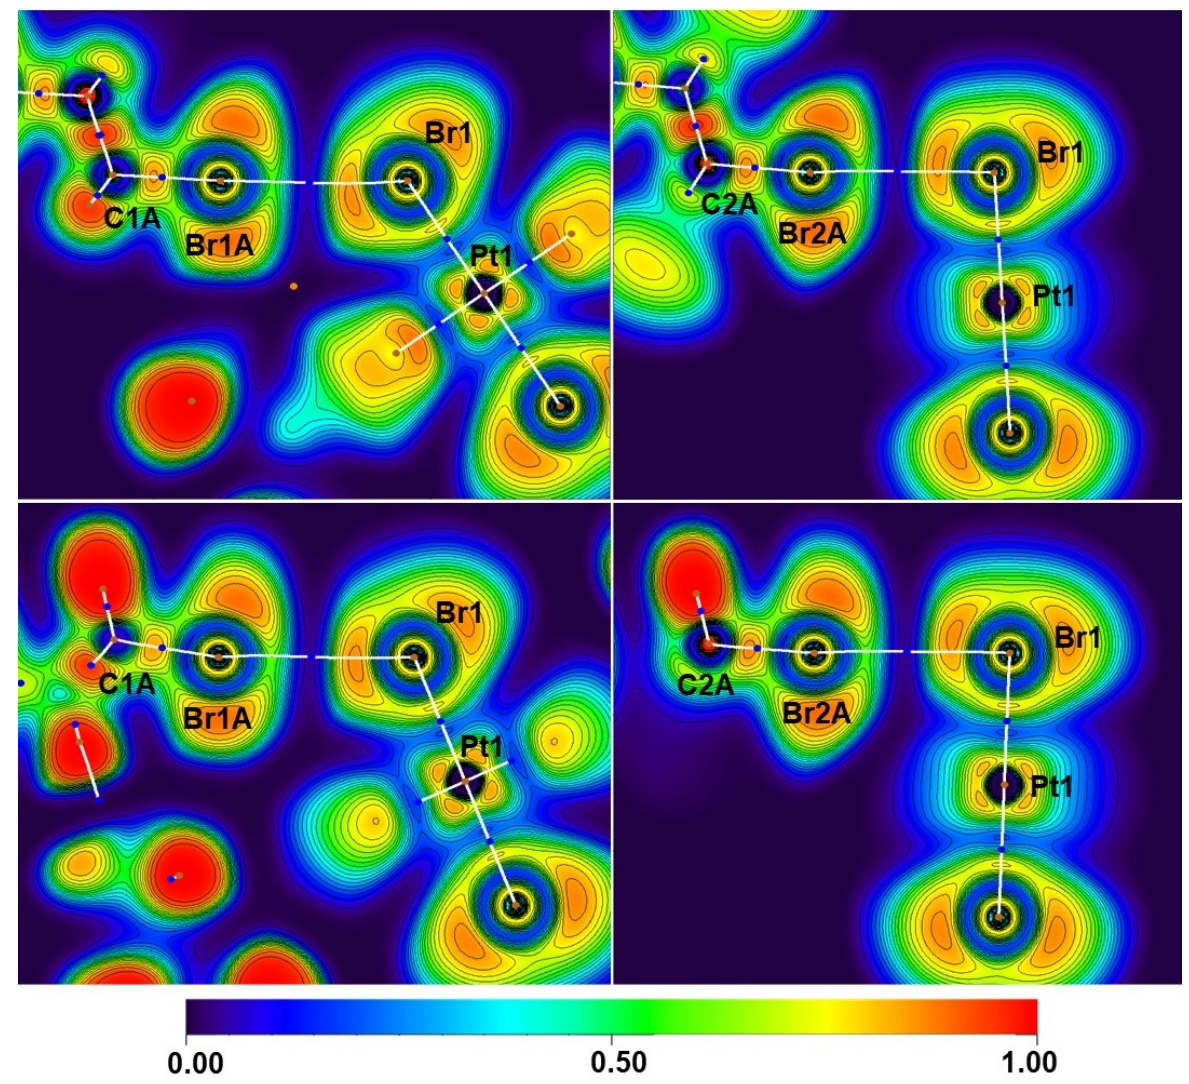
Figure 5. ELF projection and bond paths (white lines), BCPs (blue dots), NCPs (brown dots) and RCPs (orange dots) for the C1A − Br1A···Br1 − Pt1, C1A − Br2A···Br1 − Pt1 XBs in 1·tbe and 2·tbe .